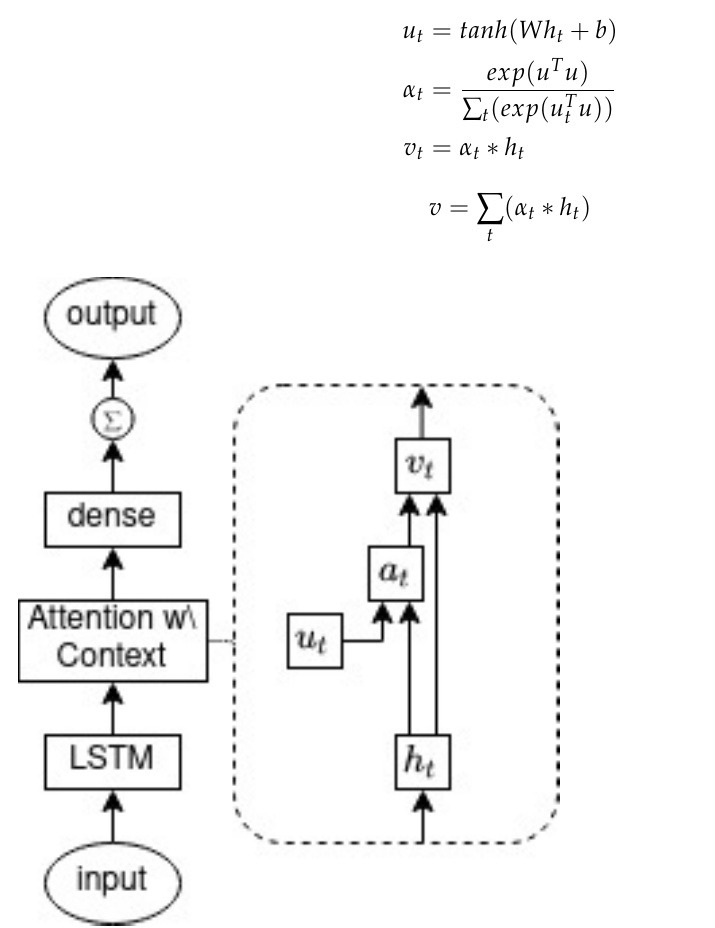
Figure 4. Attention-based